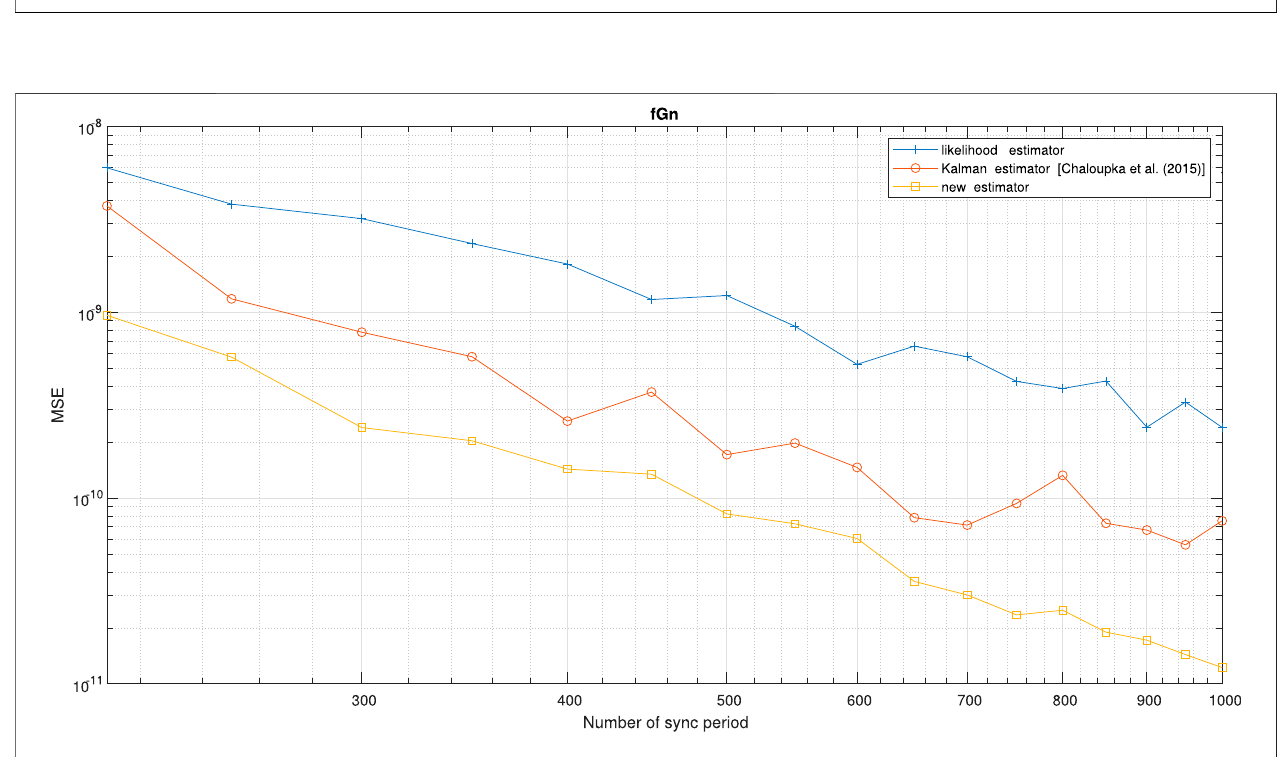
(cid:1) σ ω (cid:1) 0 . 5 ms , d (cid:1) 5 ms , d (cid:1) 5.5 ms , H (cid:1) 0.95, a (cid:1) 0.08. The results ms sm 1 2